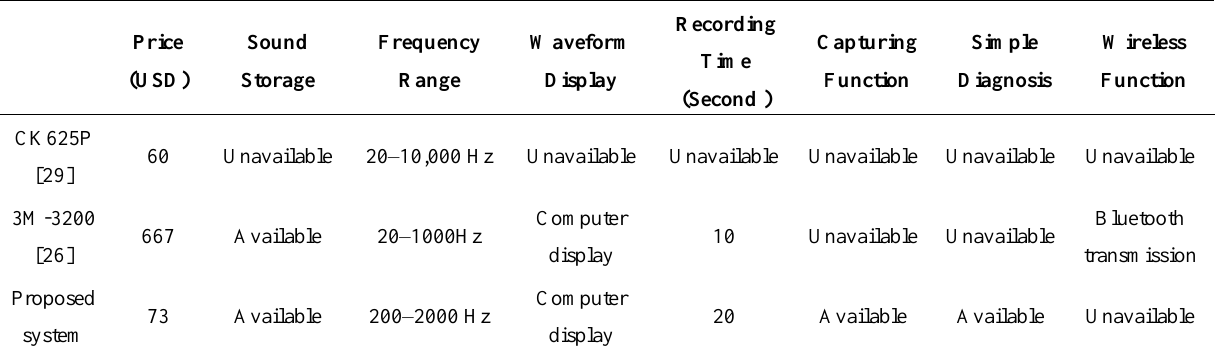
Table 15. Comparison with existing auscultation